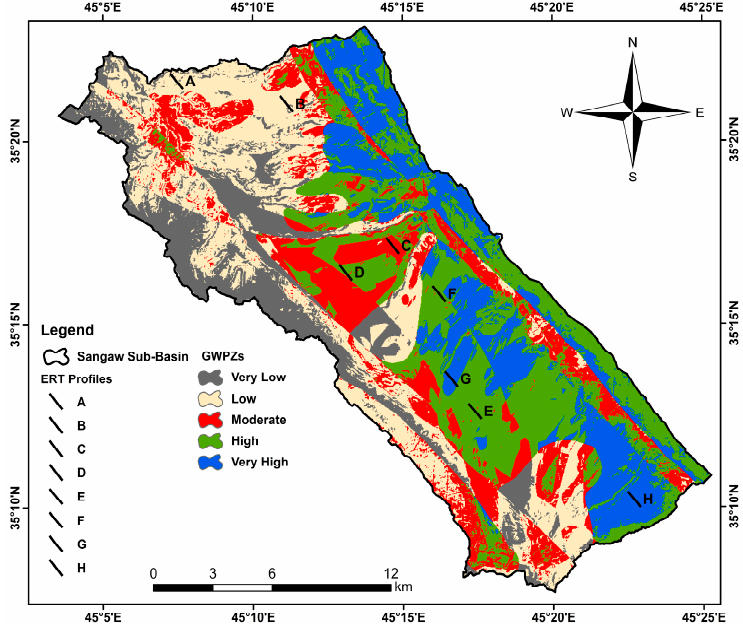
Figure 7. Validation of the GWPZ map showing ERT-profile-lines of Sangaw sub-basin.